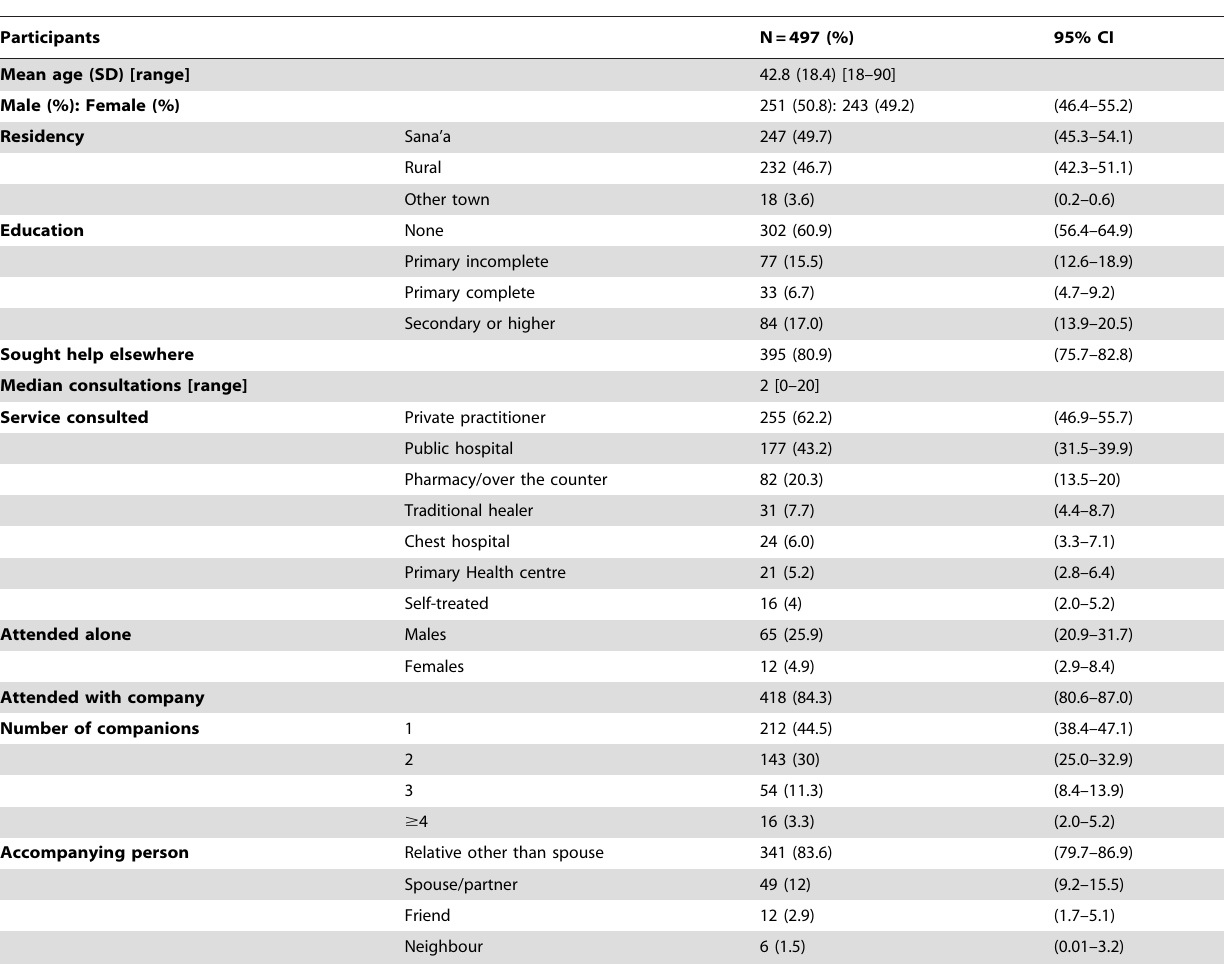
Table 1. Characteristics of participants attending TB diagnostic services and their